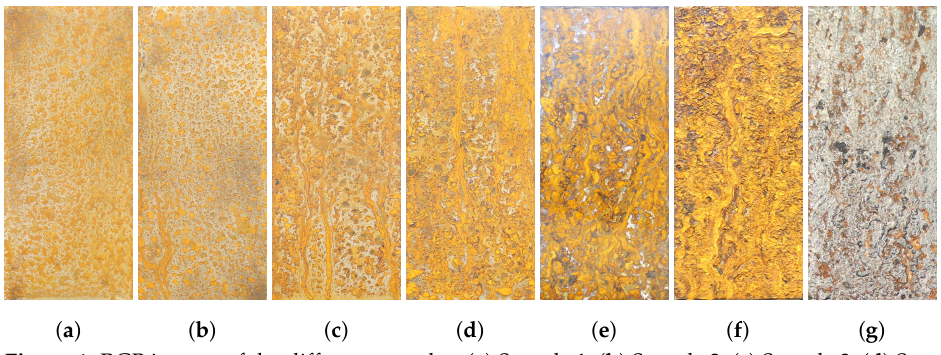
Figure 1. RGB images of the different samples. ( a ) Sample 1; ( b ) Sample 2; ( c ) Sample 3; ( d ) Sample 4; ( e ) Sample 5; ( f ) Sample 6; ( g ) Sample 7. Table 1. Overview of samples number and corresponding duration of the accelerated corrosion test. Sample